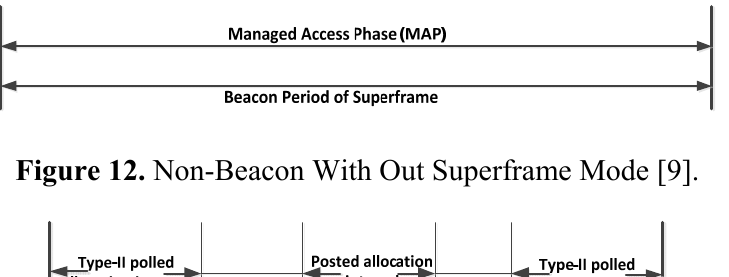
Figure 11. Layout of Access Phase in a Non-Beacon Superframe Boundary Mode [9].